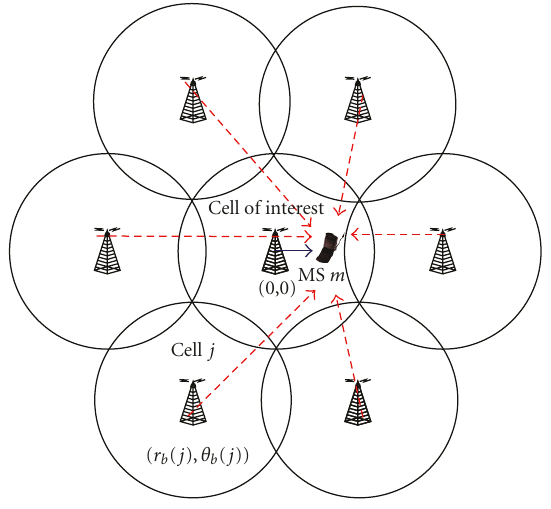
Figure 1: Locations of the CoI and the interfering BSs. Table 1: Simulation parameters.